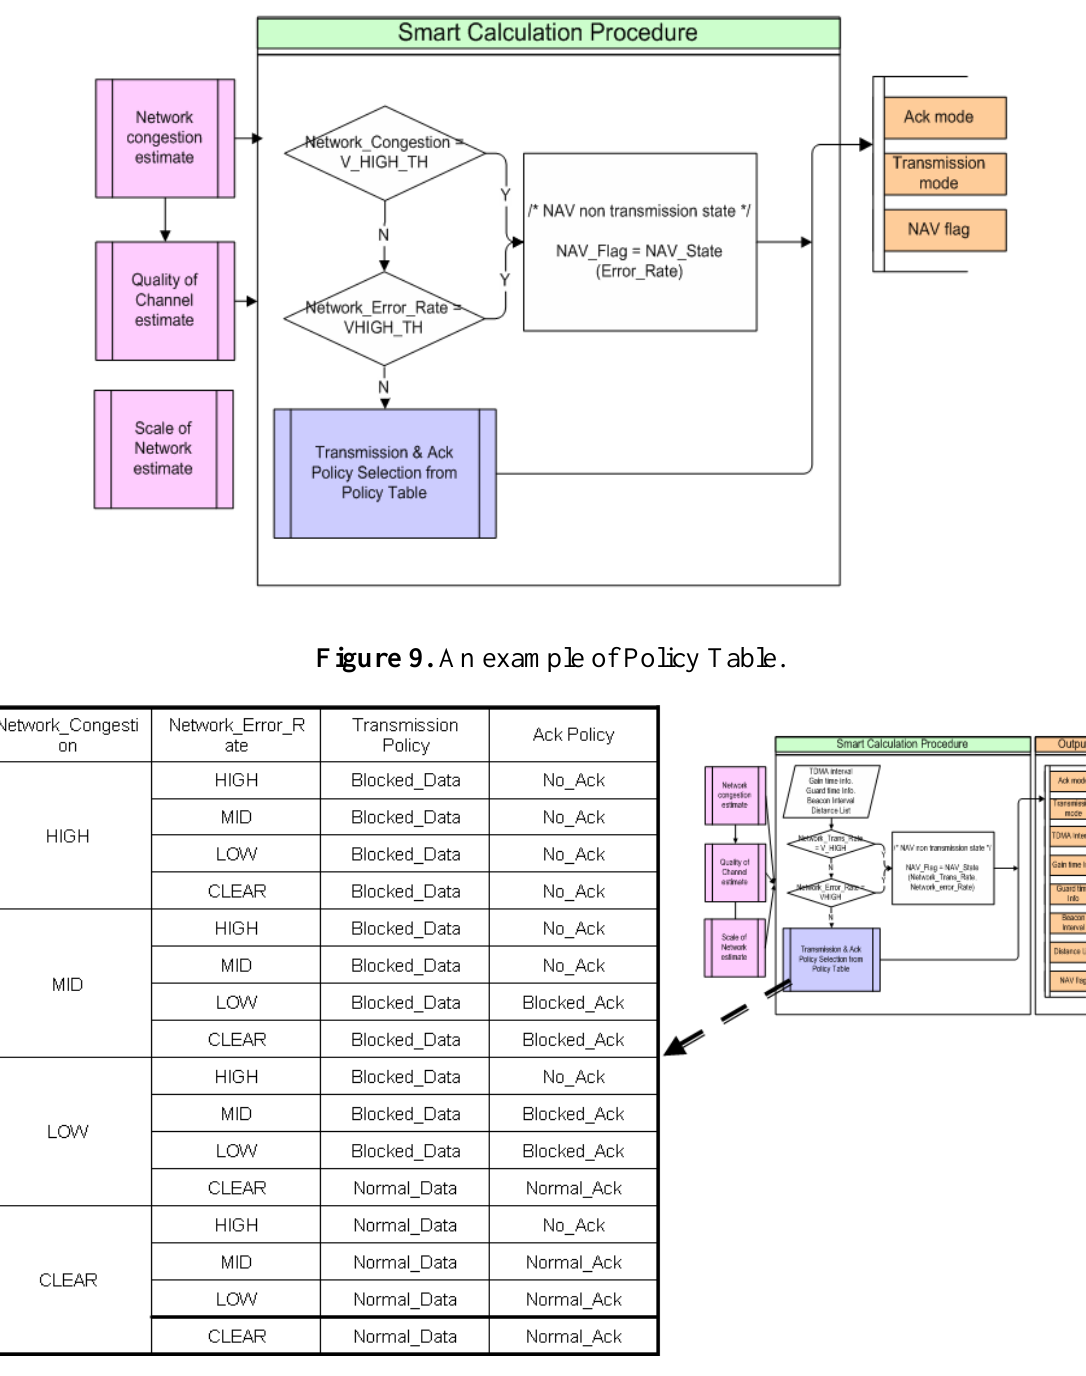
Figure 8. Smart Calculation Procedure.